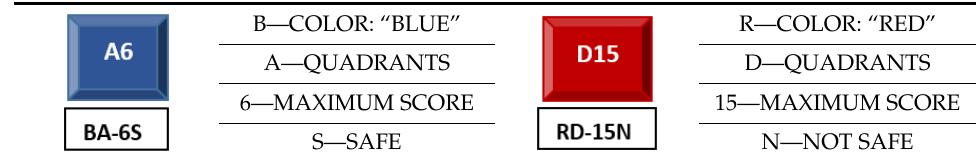
Table 1. Alphanumeric Reference Legend of the Quadrants.